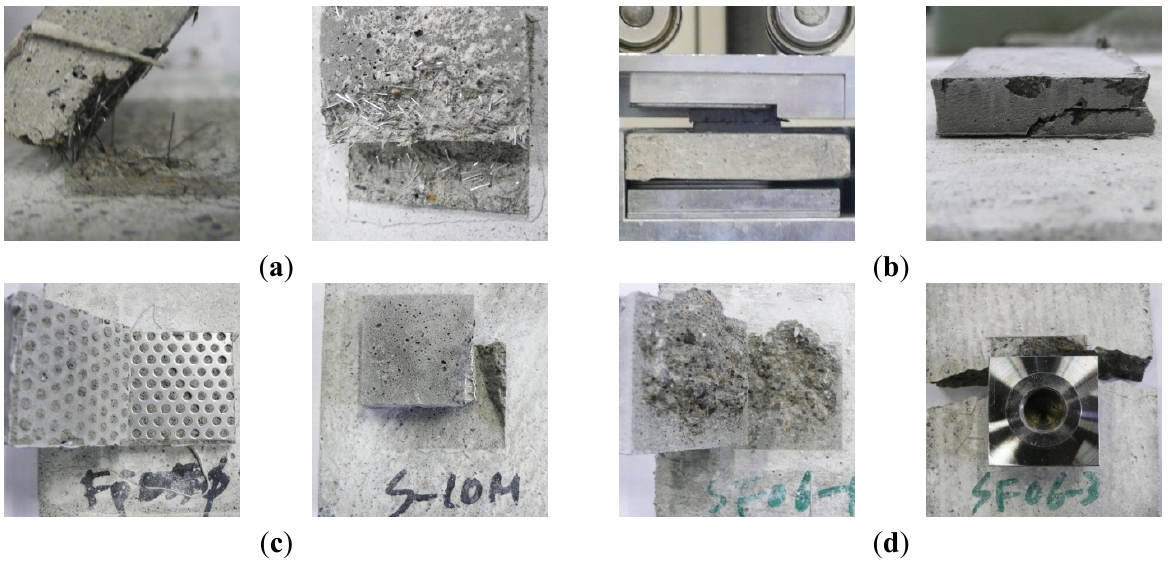
Figure 18. Shapes of bond fracture of cementitious joint using a conductive resistor. ( a ) Improvement of bond strength by mixing of steel fiber (shear); ( b ) shear fracture by metal mesh and punching metal; ( c ) fracture near punching metal (tensile) and metal mesh (shear); ( d ) exfoliation and fracture of mortar substrate